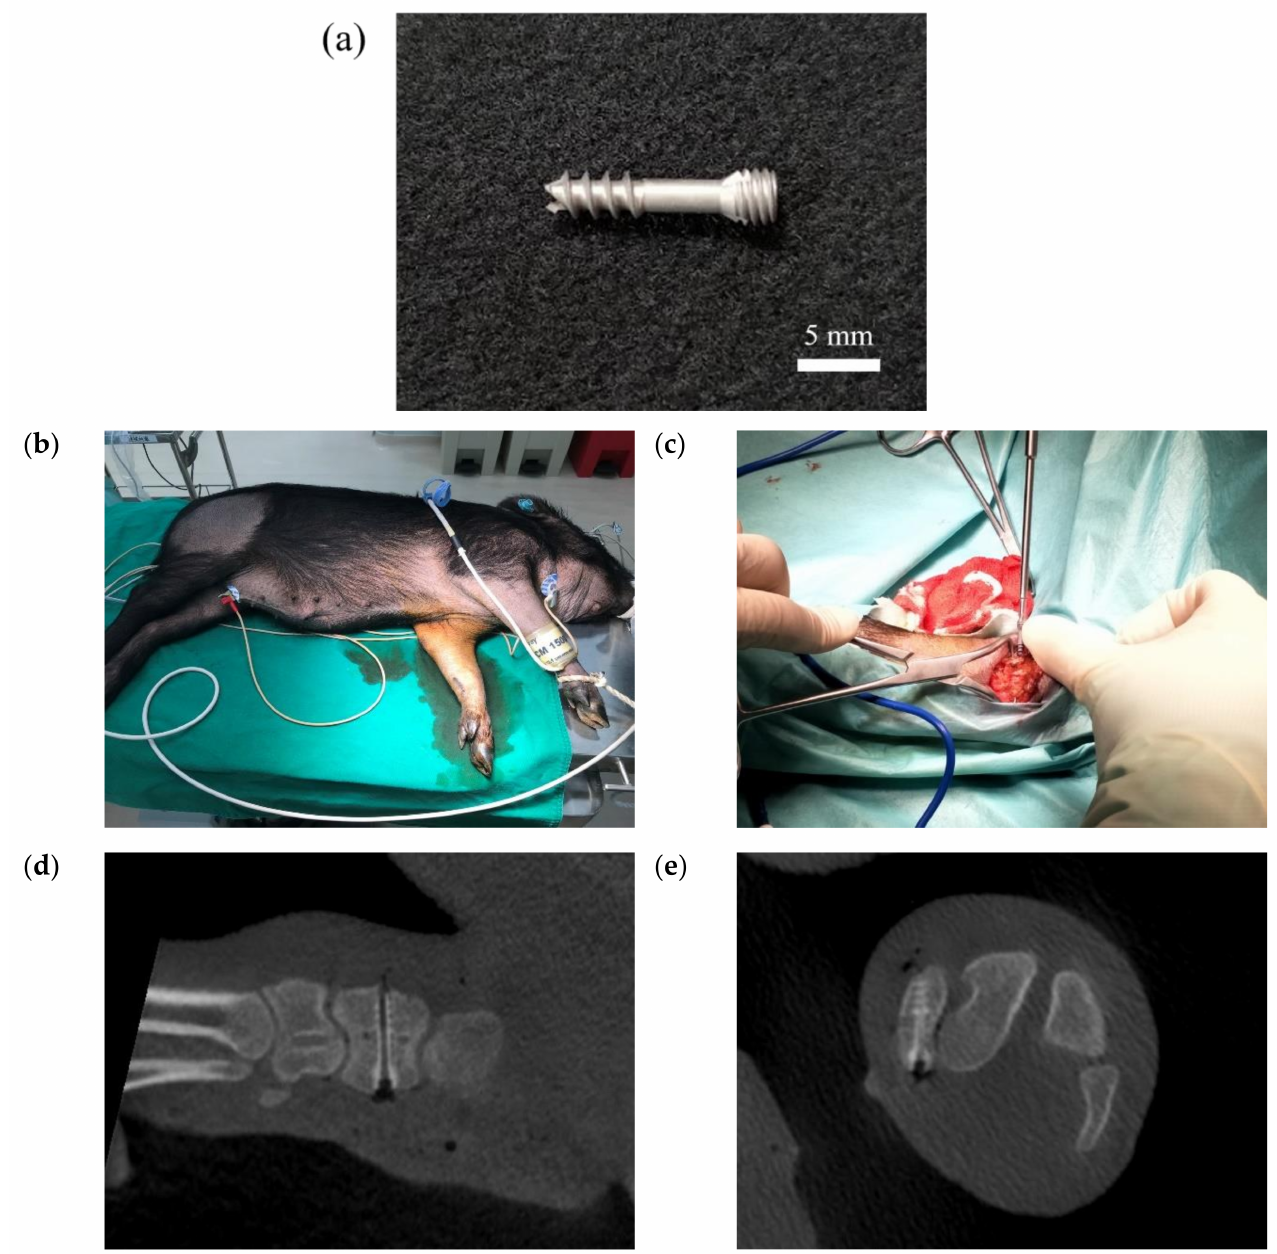
Figure 20. The ( a ) magnesium bone screw, ( b ) experimental animal, ( c ) implantation process, and ( d , e ) post-surgery CT scans in the animal